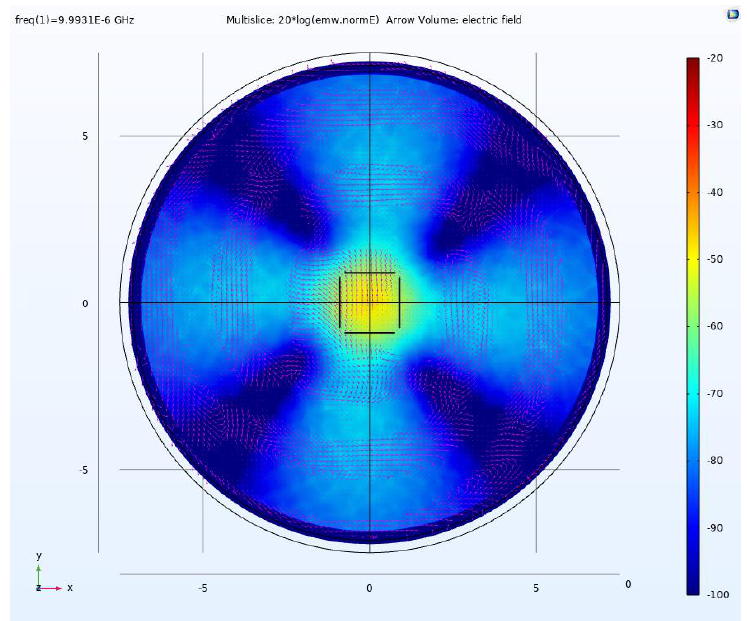
Figure 17. Electric field distribution and direction on the plane 20 km below the MD plane.